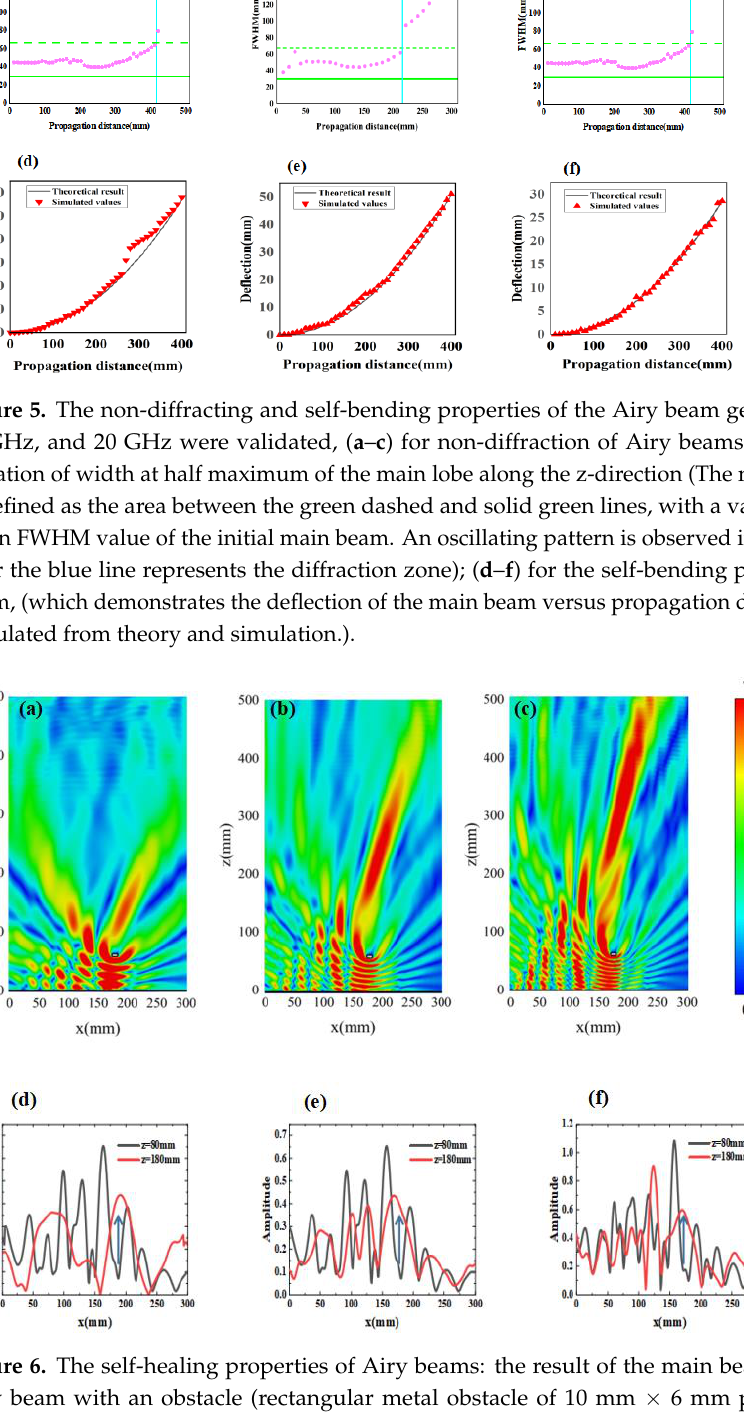
Figure 5. The non-diffracting and self-bending properties of the Airy beam generated at 10 GHz, 15 GHz, and 20 GHz were validated, ( a – c ) for non-diffraction of Airy beams, which depicts the varia- tion of width at half maximum of the main lobe along the z-direction (The non-diffraction zone is defined as the area between the green dashed and solid green lines, with a value of 1.5 times the mean FWHM value of the initial main beam. An oscillating pattern is observed in this zone, the area after the blue line represents the diffraction zone); ( d – f ) for the self-bending property of the Airy beam, (which demonstrates the deflection of the main beam versus propagation distance (z-direc- tion) calculated from theory and simulation.).